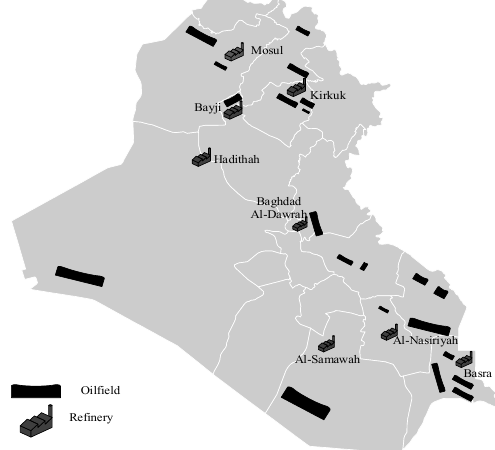
Figure 5. Iraqi oil concession